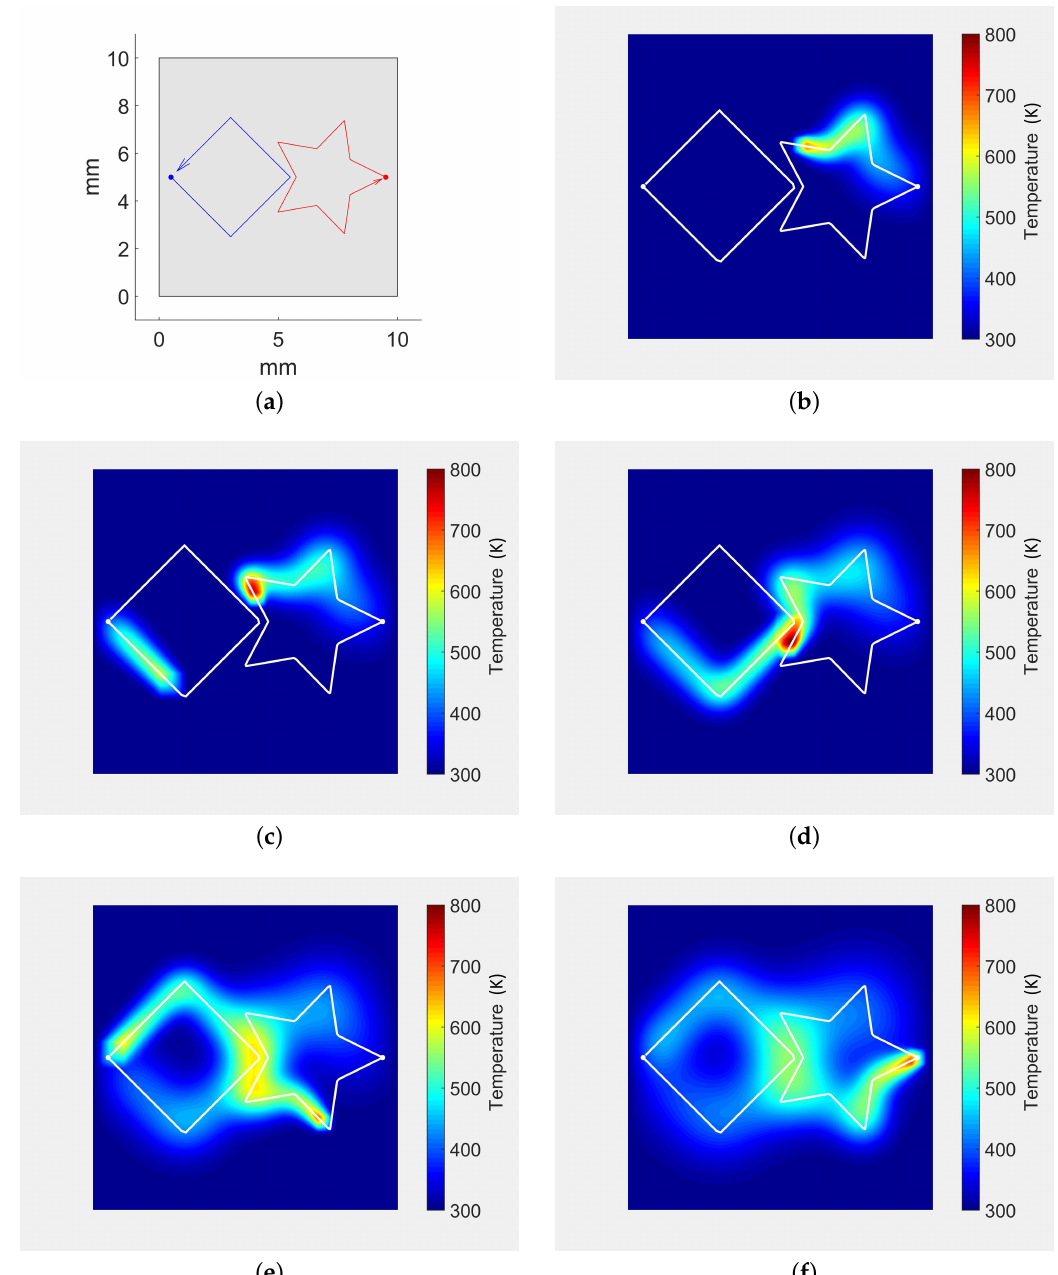
Figure 3. Laser trajectories and sheet temperature history for simultaneous diverse shape laser trajectories. ( a ) laser trajectories for the simulation; ( b ) t = 0.060 s. Only Star trajectory occurs; ( c ) t = 0.075 s. Square trajectory enters the simulation; ( d ) t = 0.094 s. Lasers are simultaneously near each other; ( e ) t = 0.13 s. Square trajectory finishes. Star trajectory continues; ( f ) t = 0.166 s. Star trajectory